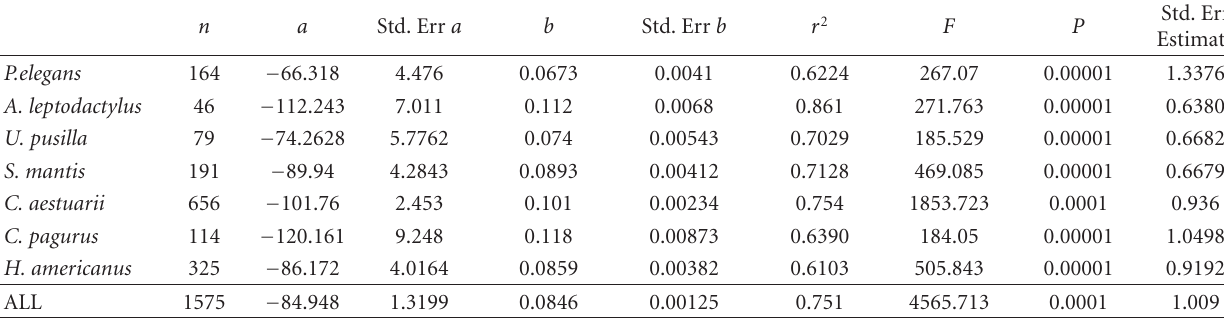
Table 1: Statistical data of linear regression.